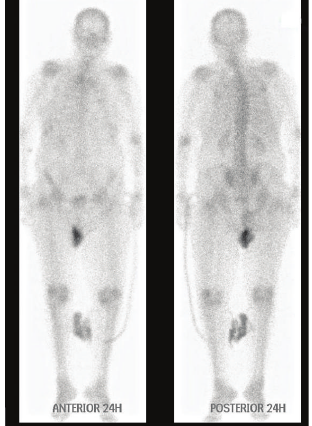
Figure 2: The gallium-67 scintigraphy revealed persistent diffuse concentration of the gallium in the ascending colon at 24-hour imaging.Gallium-67excretedintothebowelandlaxativesareessen- tial for the differential diagnosis between true positive increased bowel activity and false positive uptake due to bowel content.